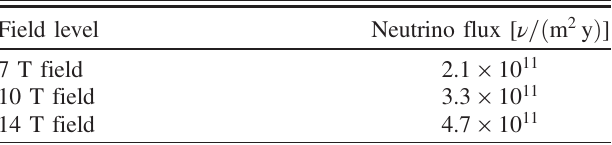
TABLE IV. Neutrino fluxes at the far detector for different capture fields at the